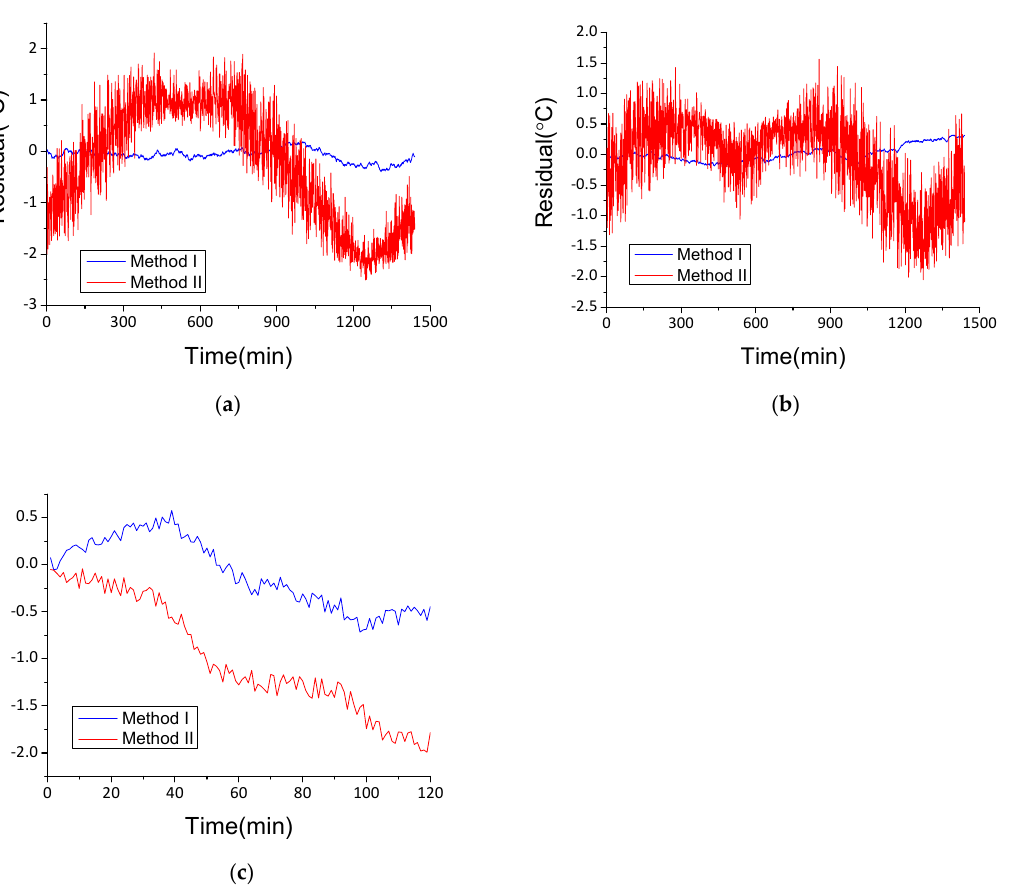
Figure 8. Residual results of Method I and II under a normal working state under different weather conditions: ( a ) winter; ( b ) summer; ( c ) cold wave. Table 4. Statistical indicators of Method I and II under a normal working state under different weather conditions.